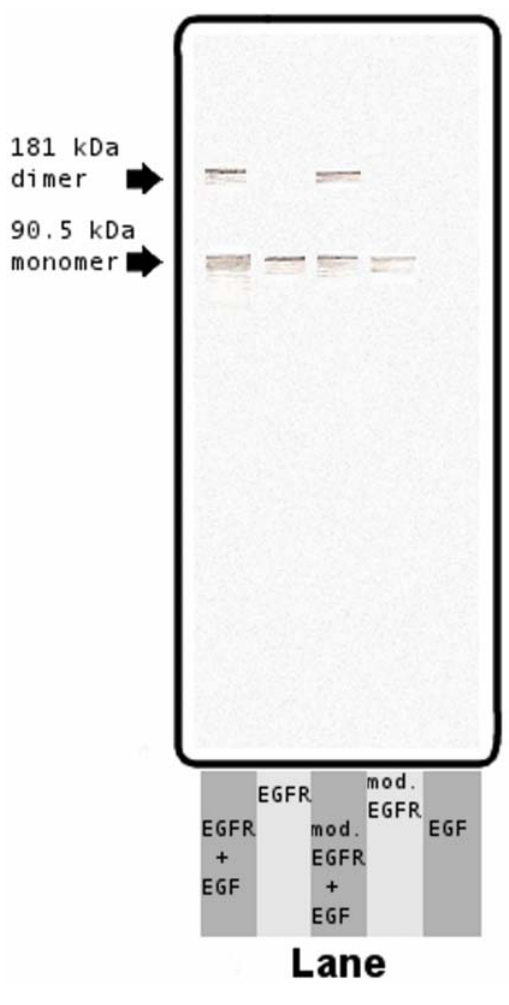
Figure 2. EGF induces dimerization of modified EGF receptors. SDS-PAGE analysis of EGFR dimerization. EGFR + EGF Lane, unmodified EGF receptors with EGF present. EGFR Lane, unmodified EGF receptors without EGF present. mod. EGFR + EGF Lane, modified EGF receptors with EGF present. mod. EGFR Lane, modified EGF receptors without EGF present. EGF Lane, only EGF present (no EGF receptors present).